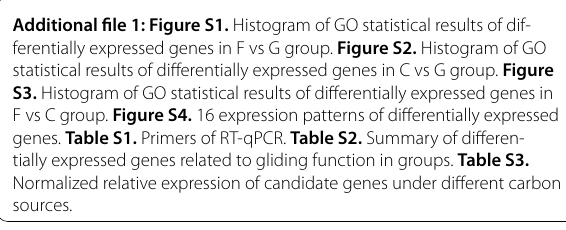
F vs C group. Figure S4. 16 expression patterns of differentially expressed genes. Table S1. Primers of RT-qPCR. Table S2. Summary of differen- tially expressed genes related to gliding function in groups. Table S3. Normalized relative expression of candidate genes under different carbon